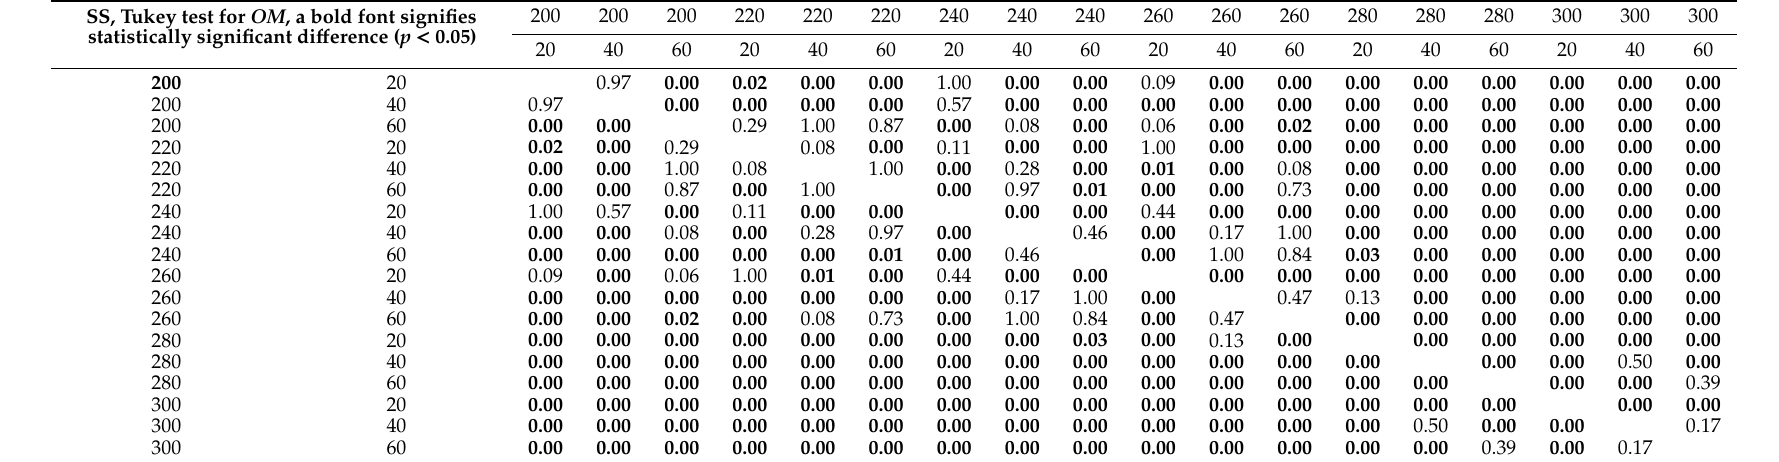
Table A8. Analysis of variance for organic matter content of sewage sludge.